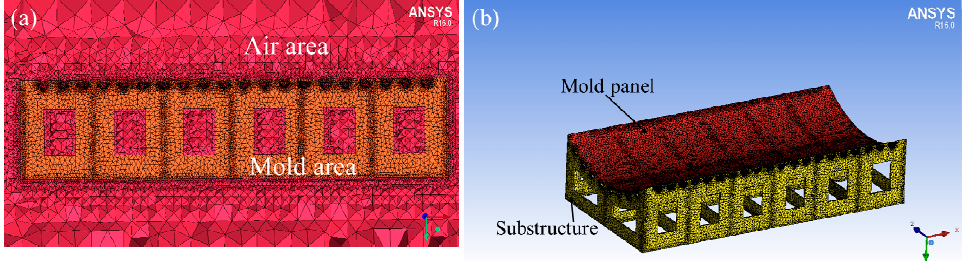
Figure 7. ( a ) The side view of fluid-solid conjugated mesh interface, ( b ) the mesh of mold.